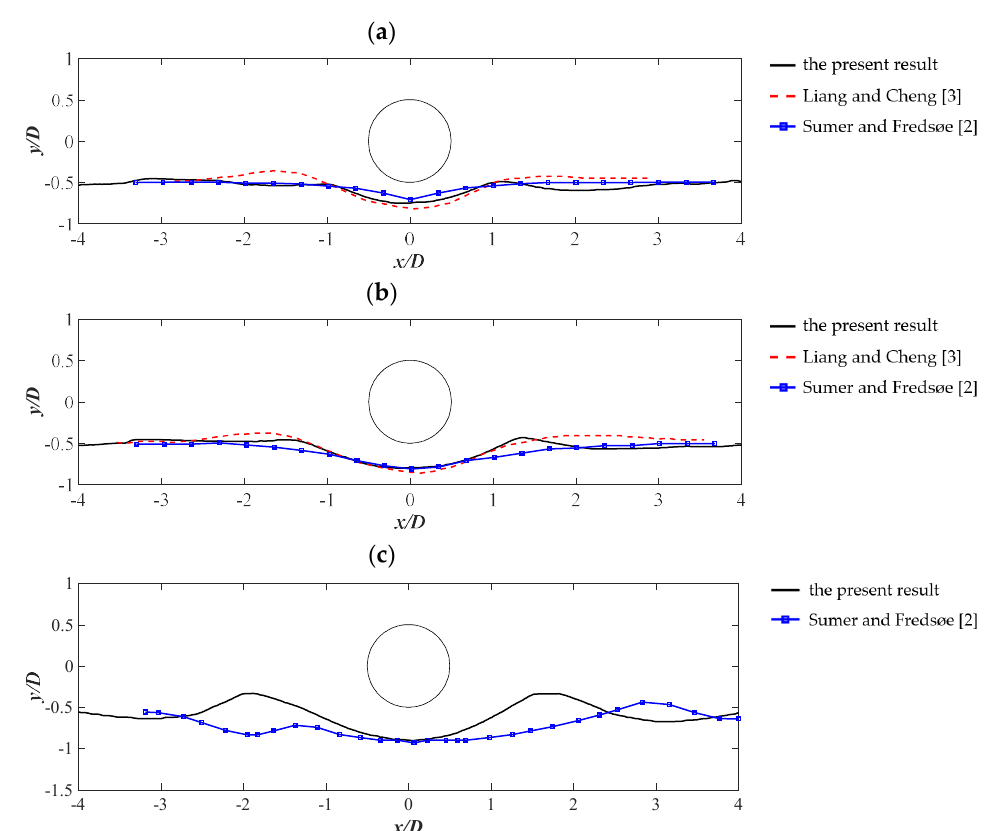
Figure 5. Comparison of the present predicted sediment profile obtained using Mesh 2 (solid black line) with the experi- mental data reported by Sumer and Fredsøe [2] (data adapted from Sumer and Fredsøe, 1990, blue squares) and numerical simulation results obtained by Liang and Cheng [10] (data adapted from Liang and Cheng, 2005, red dashed lines) at ( a ) t = 30 s; ( b ) t = 60 s; ( c ) t = 180 s compared with the equilibrium state of the result by Sumer and Fredsøe [2].